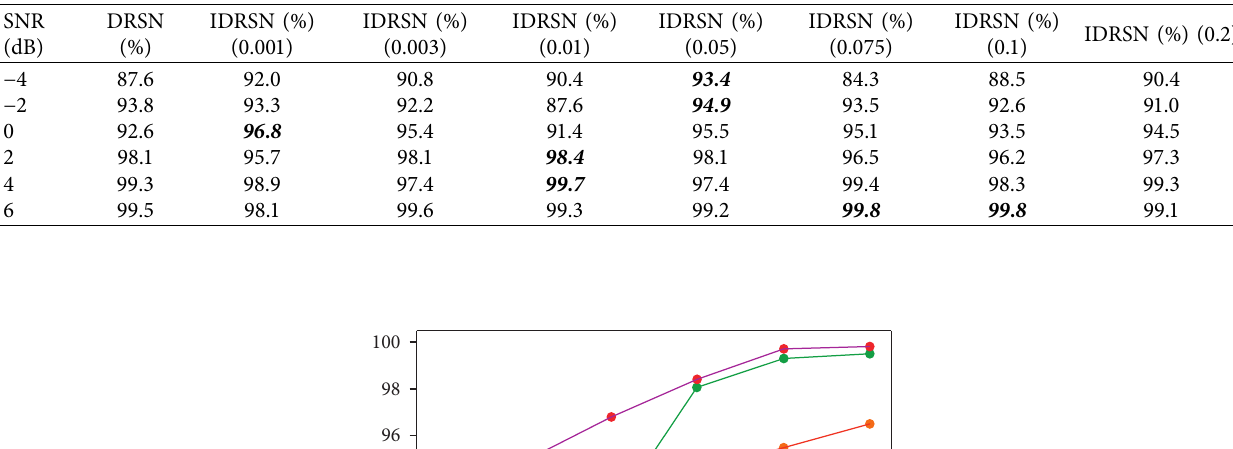
Figure 8: Fault diagnosing accuracy of IDRSN and DRSN under different noise Table 4: Fault diagnosing accuracy results of the normalized DRSN and normalized IDRSN.